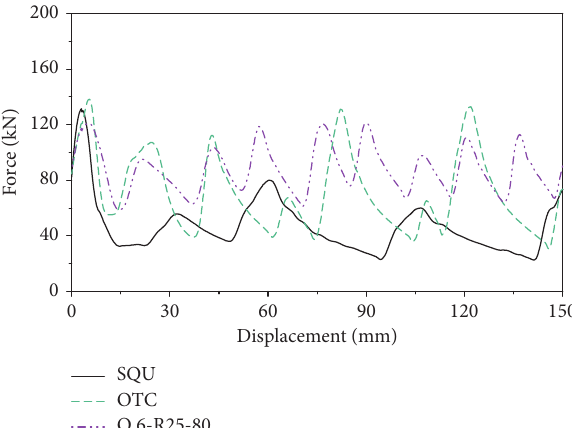
Figure 13: Force-displacement curves of the traditional square and octagonal tubes and the proposed octagonal prefolded